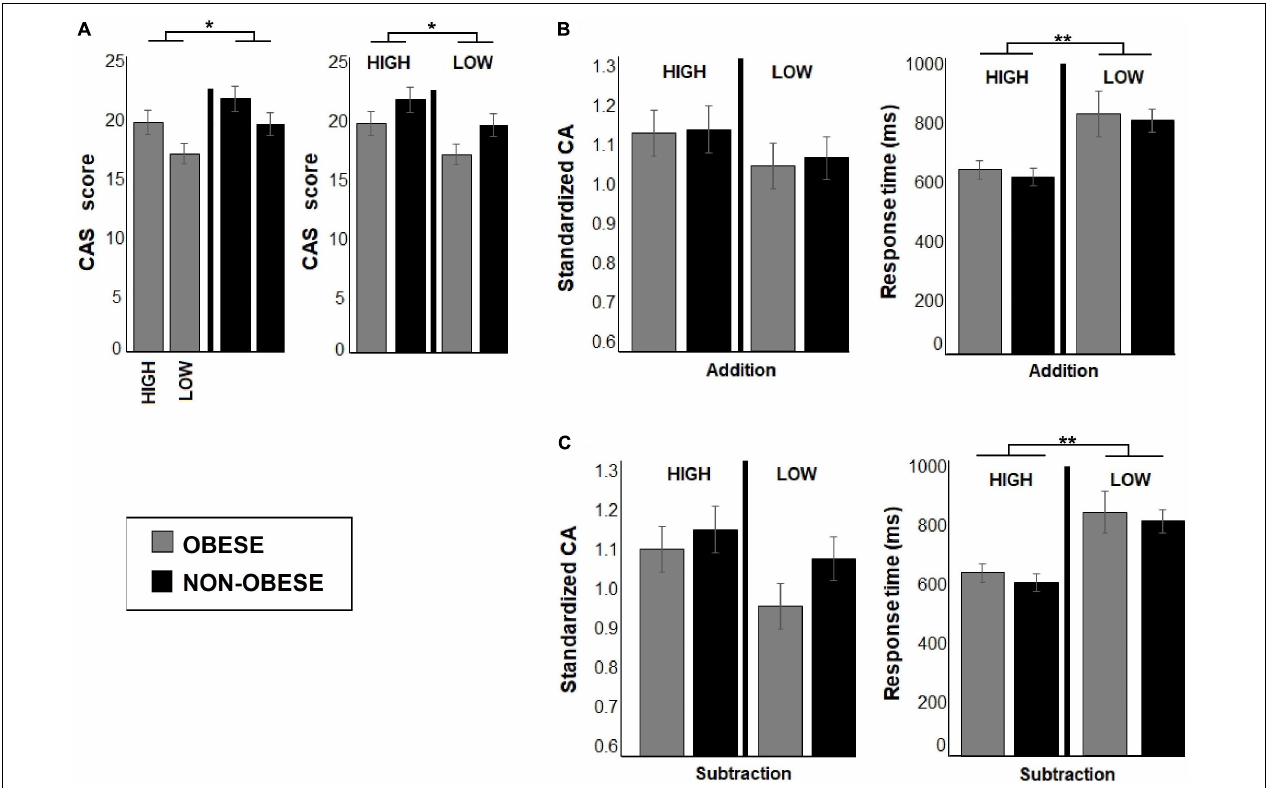
FIGURE 3 | The bar graphs show behavioral performance during addition and subtraction conditions for each subgroup after clustering analyses. In (A) bar graphs show the differences between weight groups and math skill levels in CAS scores, while (B,C) illustrate accuracy and response times (RTs) in math task for addition and subtraction conditions for all subgroups. Both bar graphs show differences between preteens with high and low math skill level in RTs. The preteens with low math skills displayed longer RTs than the high performers in both experimental conditions. Significant p -values were represented as follows: * p < 0.05, ** p <